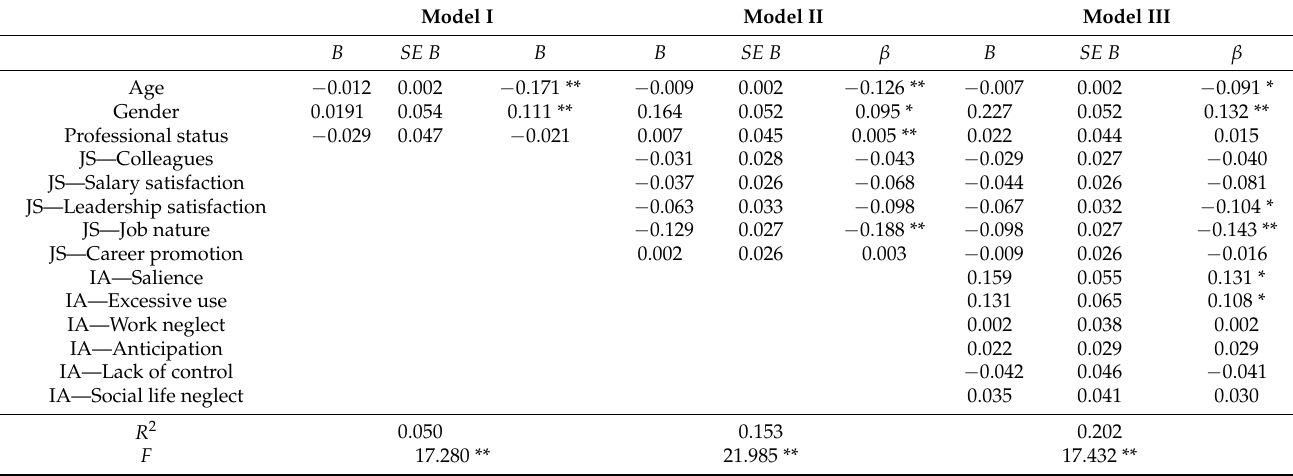
Table 5. Hierarchical linear regression analysis predicting mental health symptoms ( N =